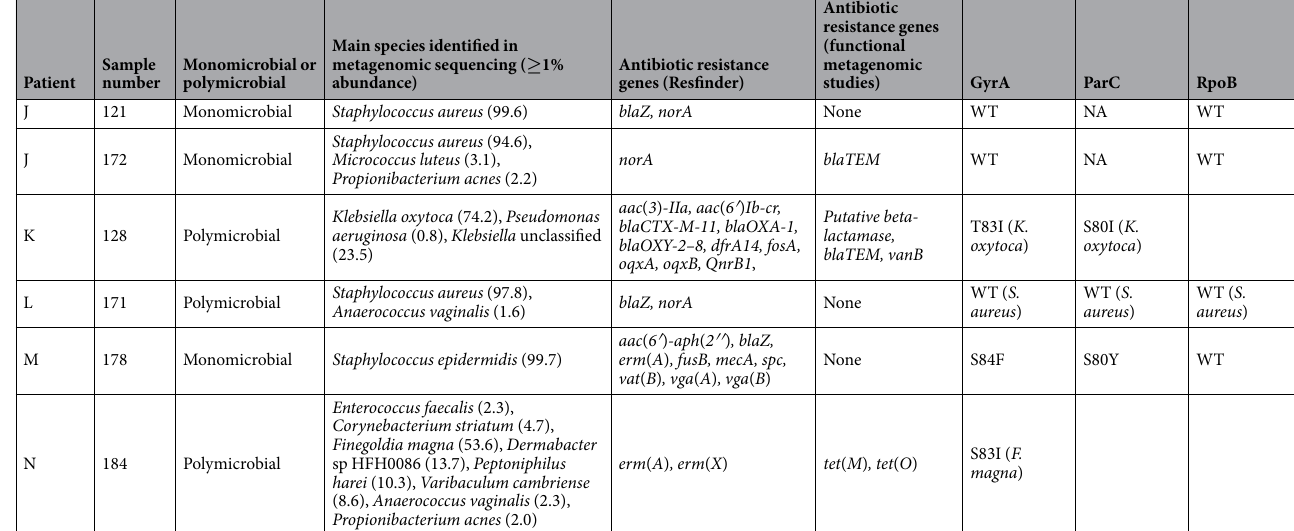
Table 3. Results of the metagenomic sequencing of the 24 samples analysed in this study and antibiotic resistance determinants. WT: wild-type. NA: not